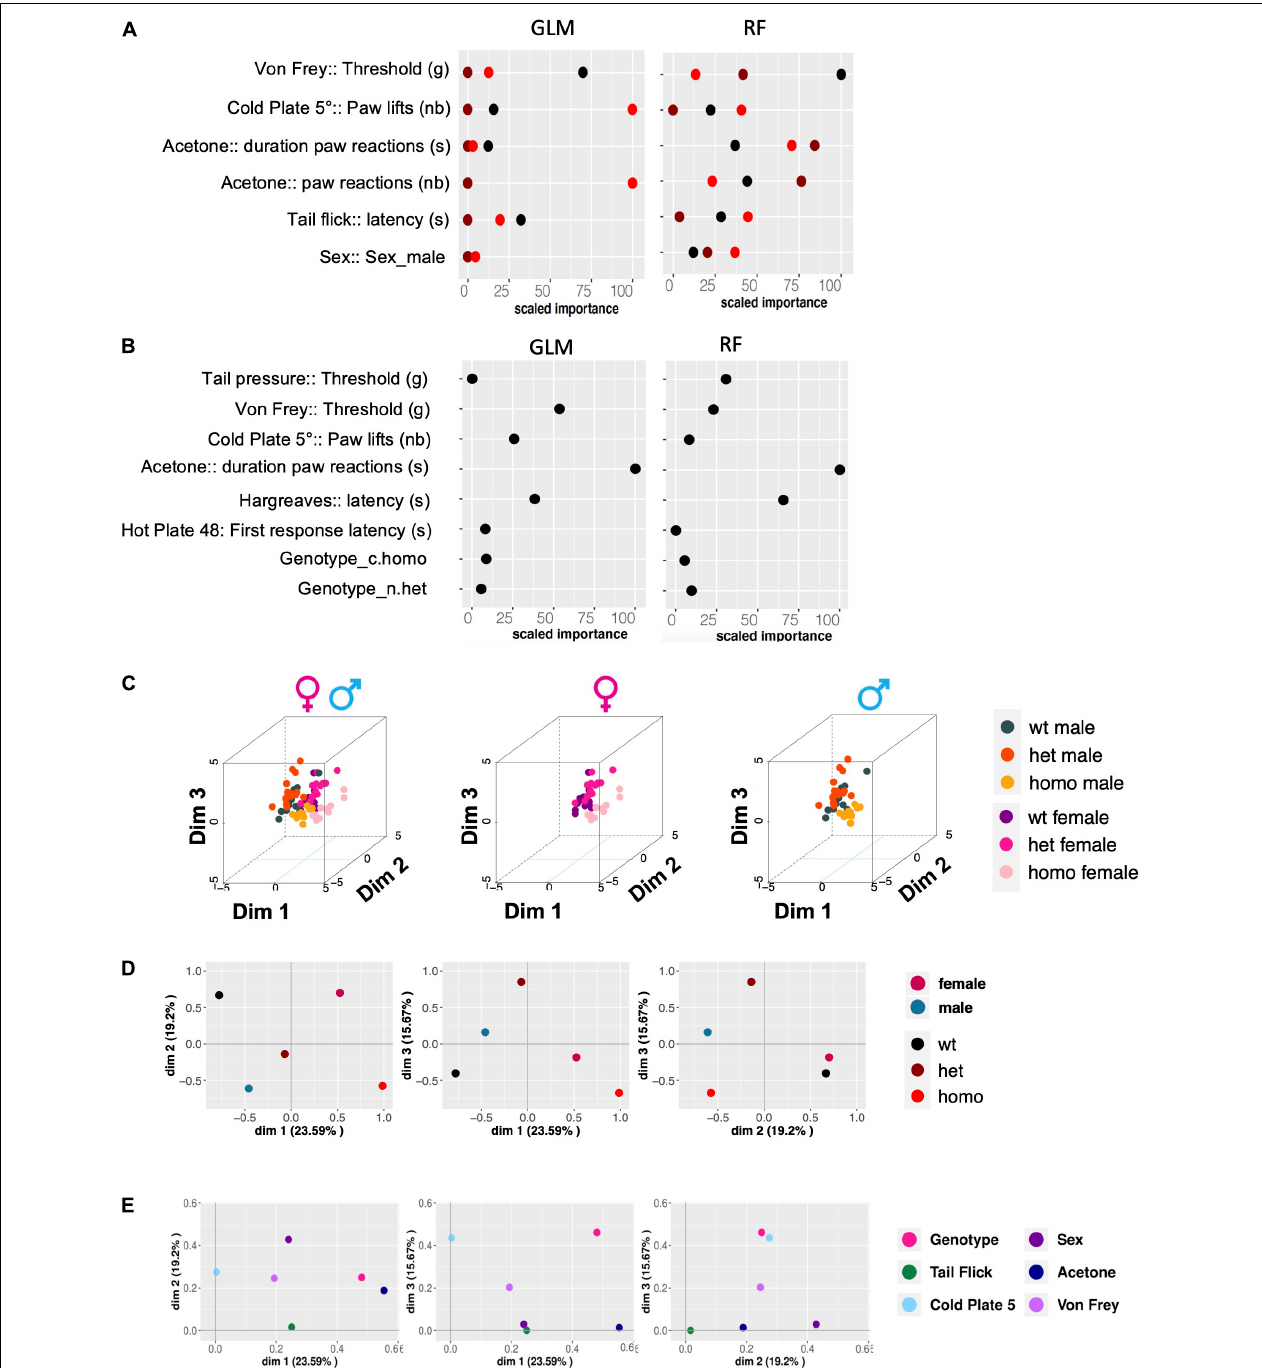
FIGURE 5 | Gdaphen analyses to identify the variables contributing the most to genotype and sex discrimination. (A) Identification of the power of each explanatory phenotypic variable to the genotype discrimination. GLM, Generalized Linear Model; RF, Random Forest. The explanatory variables selected were the ones found to contribute more than a 30% to the genotype discrimination. (B) Identification of the power of the explanatory phenotypic variables contributing to more than 30% to the genotype discrimination, analyzed to see for different responses based on sex and using the two different statistical GLM and RF classifiers. (C) 3D-PCA plots showing the individual animals clustering in 3D space based on PCA analyses performed with all the phenotypic variables and colors based on the genotype and sex. Left panel shows individuals of both sexes, the middle plots female data, and the right plot male data. (D,E) The qualitative variable discrimination component maps show the distribution in 2D space of the qualitative variables coordinates calculated based on PCA analysis performed with the multifactor analysis of mixed data (MFA). In panel (D) , the variables female, male, wt, het, and homo are represented. In panel (E) , the variables genotype, sex, tail flick, acetone, cold plate, and von Frey are